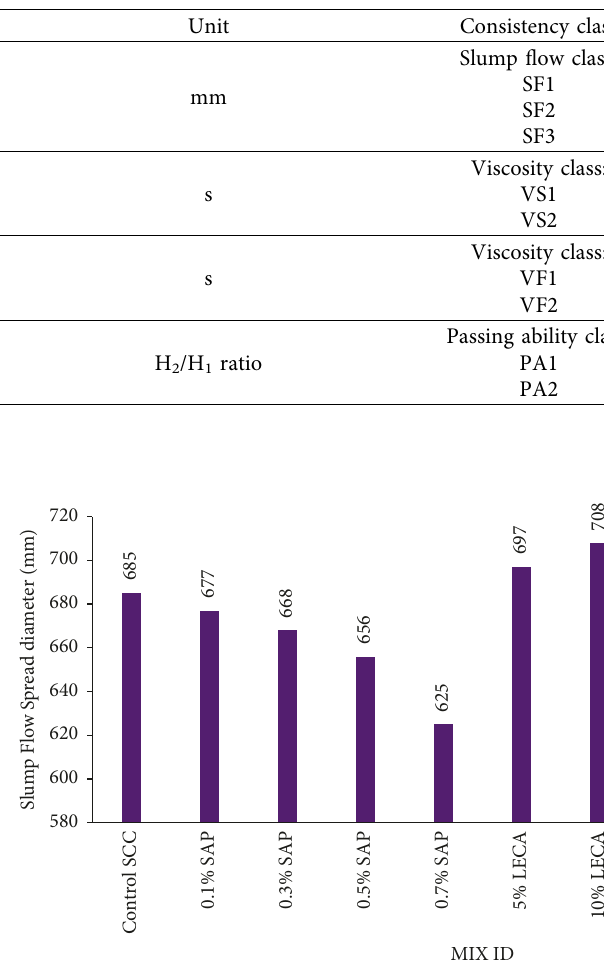
Table 6: SCC fresh properties tests: consistency class as per EFNARC 2005